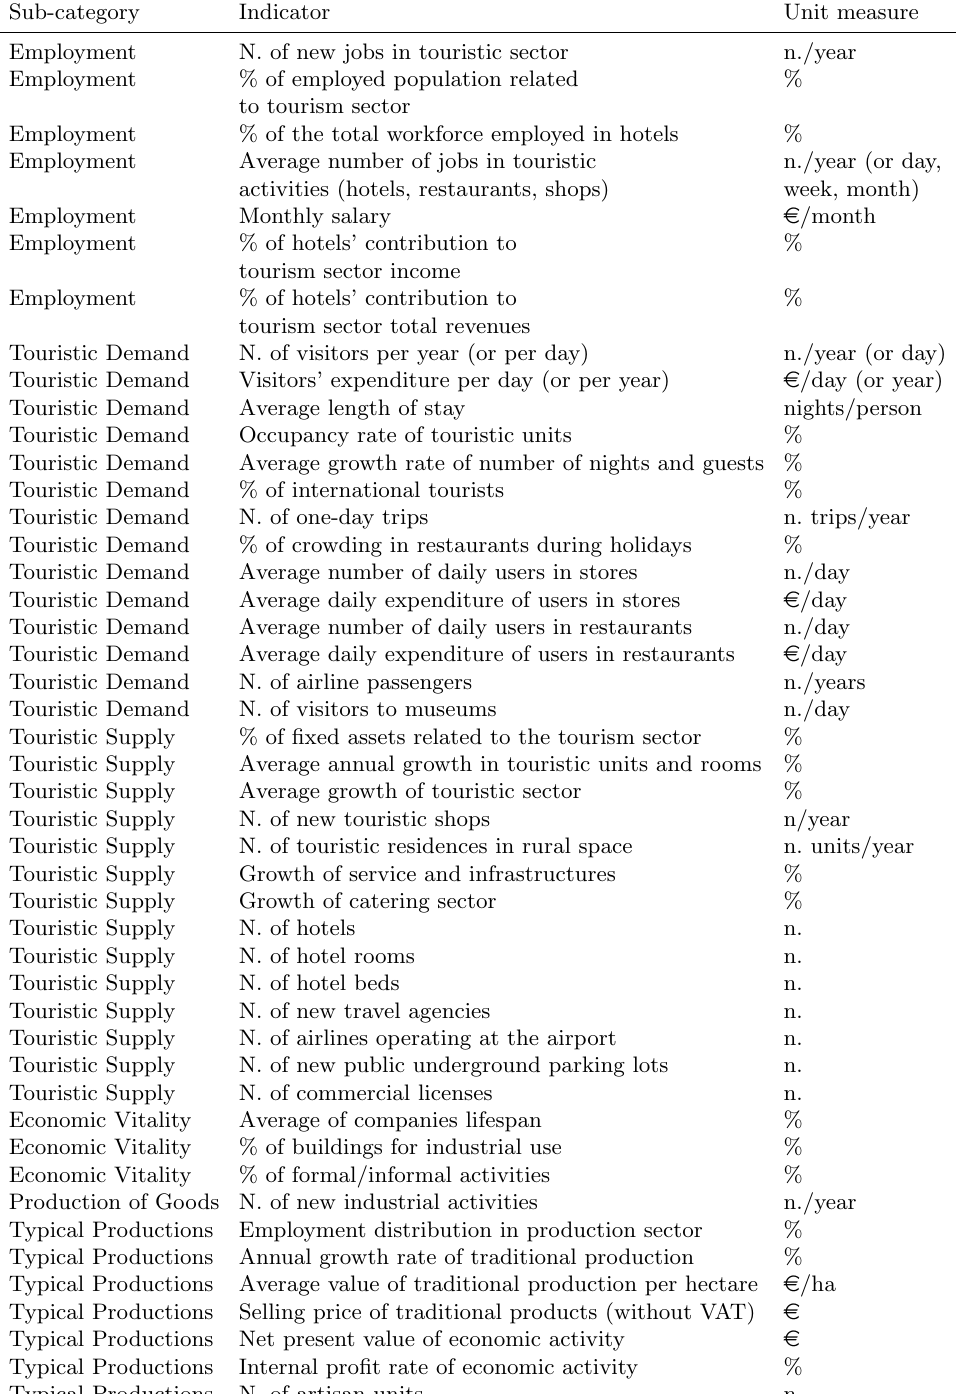
Table 1: Tourism and recreation